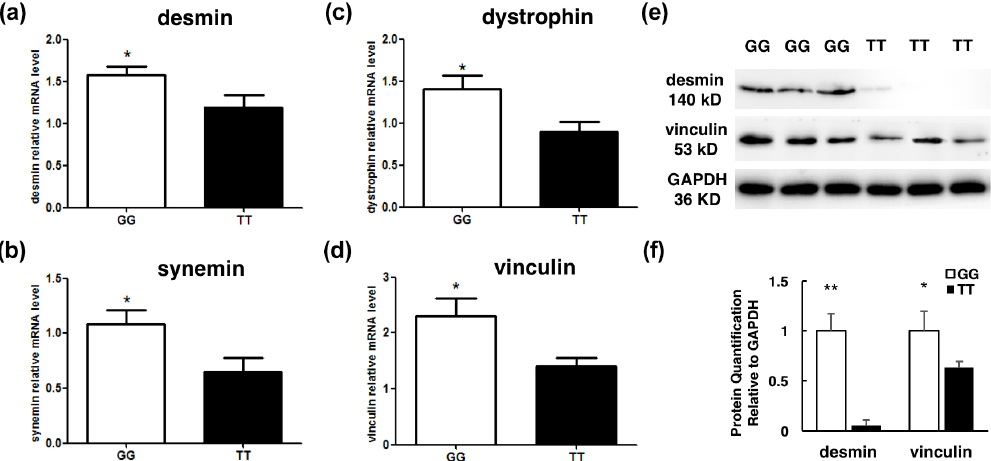
Figure 5. The mRNA expression level detection of cytoskeletal proteins between two groups with different genotypes. (a–d) RT-qPCR was performed to detect the mRNA level of desmin , dystrophin , synemin , and vinculin in the individuals with the GG ( n = 13) and TT ( n = 9) genotypes. (e–f) Western blot was performed to detect the protein of desmin and vinculin in the individuals with the GG ( n = 3) and TT ( n = 3) genotypes. Results are presented as mean ± SEM ∗ P< 0 . 05; ∗∗ P< 0 . 01.